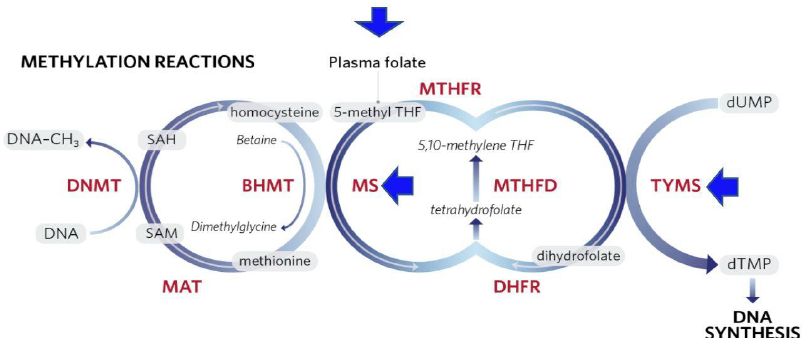
Figure 2. Folate acts as a shuttle for methyl groups that will be used in the metabolism of s-adenosyl methionine (SAM), in de novo synthesis of purines and thymidylate. Dihydrofolate reductase (DHFR) is an enzyme that reduces dihydrofolate to tetrahydrofolate. Arrows point to potential target sites for alcohol-induced changes in methionine cycle function. BHMT = betaine homocysteine methyl transferase; MTHFD = methylenetetrahydrofolate dehydrogenase; DNMT = DNA methyl transferase; MTHFR = methylenetetrahydrofolate reductase; MAT = methionine adenosyltransferase; SAH = S-adenosyl homocysteine; MS = methionine synthase; TYMS = thymidylate synthetase.